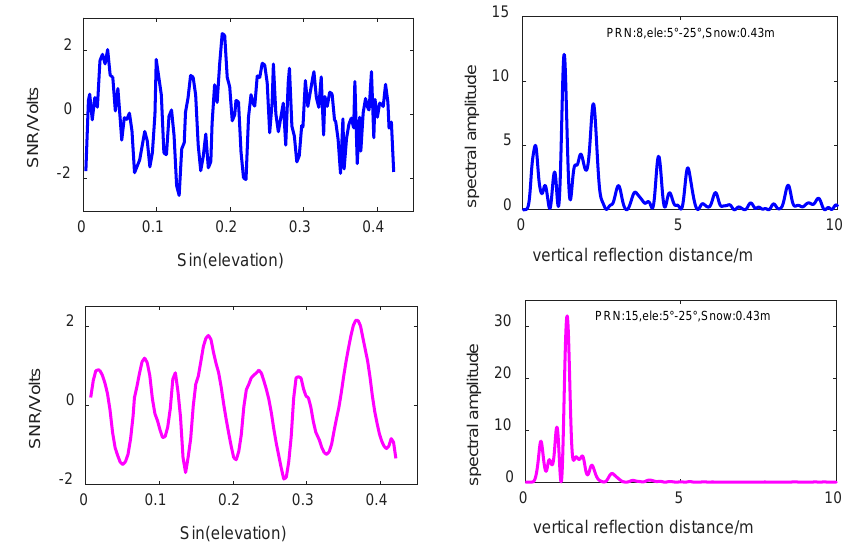
Figure 3 L1 band SNR residual sequence and L-S spectrum compare the accuracy of polynomial and wavelet decomposition in snow depth inversion, as shown in figure 4, it is a comparison diagram between the inversion snow depth result of quadratic polynomial and wavelet analysis and the measured snow depth value. In the figure, the x-coordinate represents the inversion date, and the y-coordinate represents the inversion snow depth value of db4 wavelet 2-layer decomposition SNR data, respectively. It can be seen from the figure that the inversion value of wavelet analysis and quadratic polynomial fluctuates around the actual value. It can also be seen that the snow depth value used for snow depth inversion after wavelet denoising is closer to the actual value. By calculation, RMSE value of polynomial inversion snow depth is 8cm with an error of 7cm, and RMSE value of wavelet de-noising inversion snow depth is 5cm with an error of 3cm.In the snow-free stage, the inversion value of the two methods fluctuates greatly with the actual value, which may be due to the arrival of summer, when the temperature gradually increases, leading to snow melt and little or no snow on the surface. Therefore, the inversion values of the two methods need to be